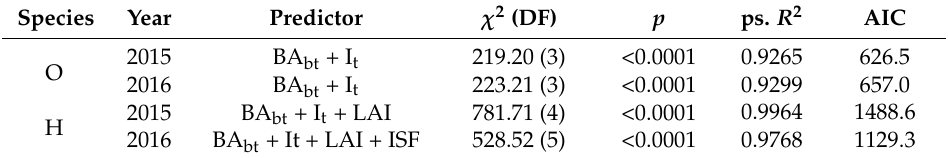
Table 3. The goodness of fit characteristics of the number of live new sprouts model for both species.